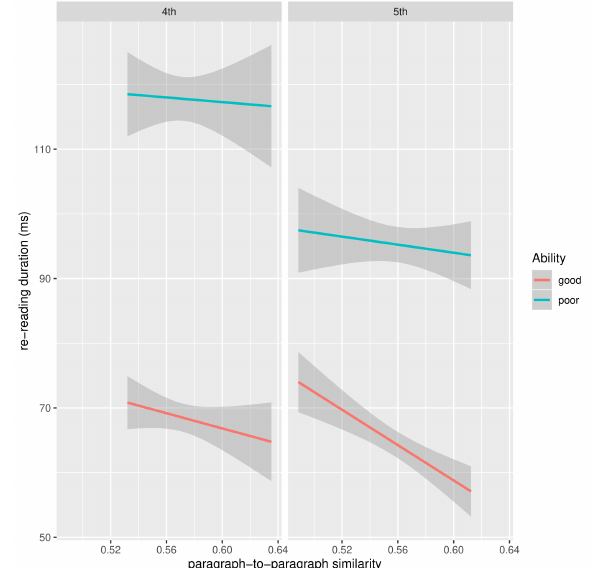
Figure 8. RRD for 4th and 5th grade as a function of current and preceding paragraph similarity and reading ability: random effects removed